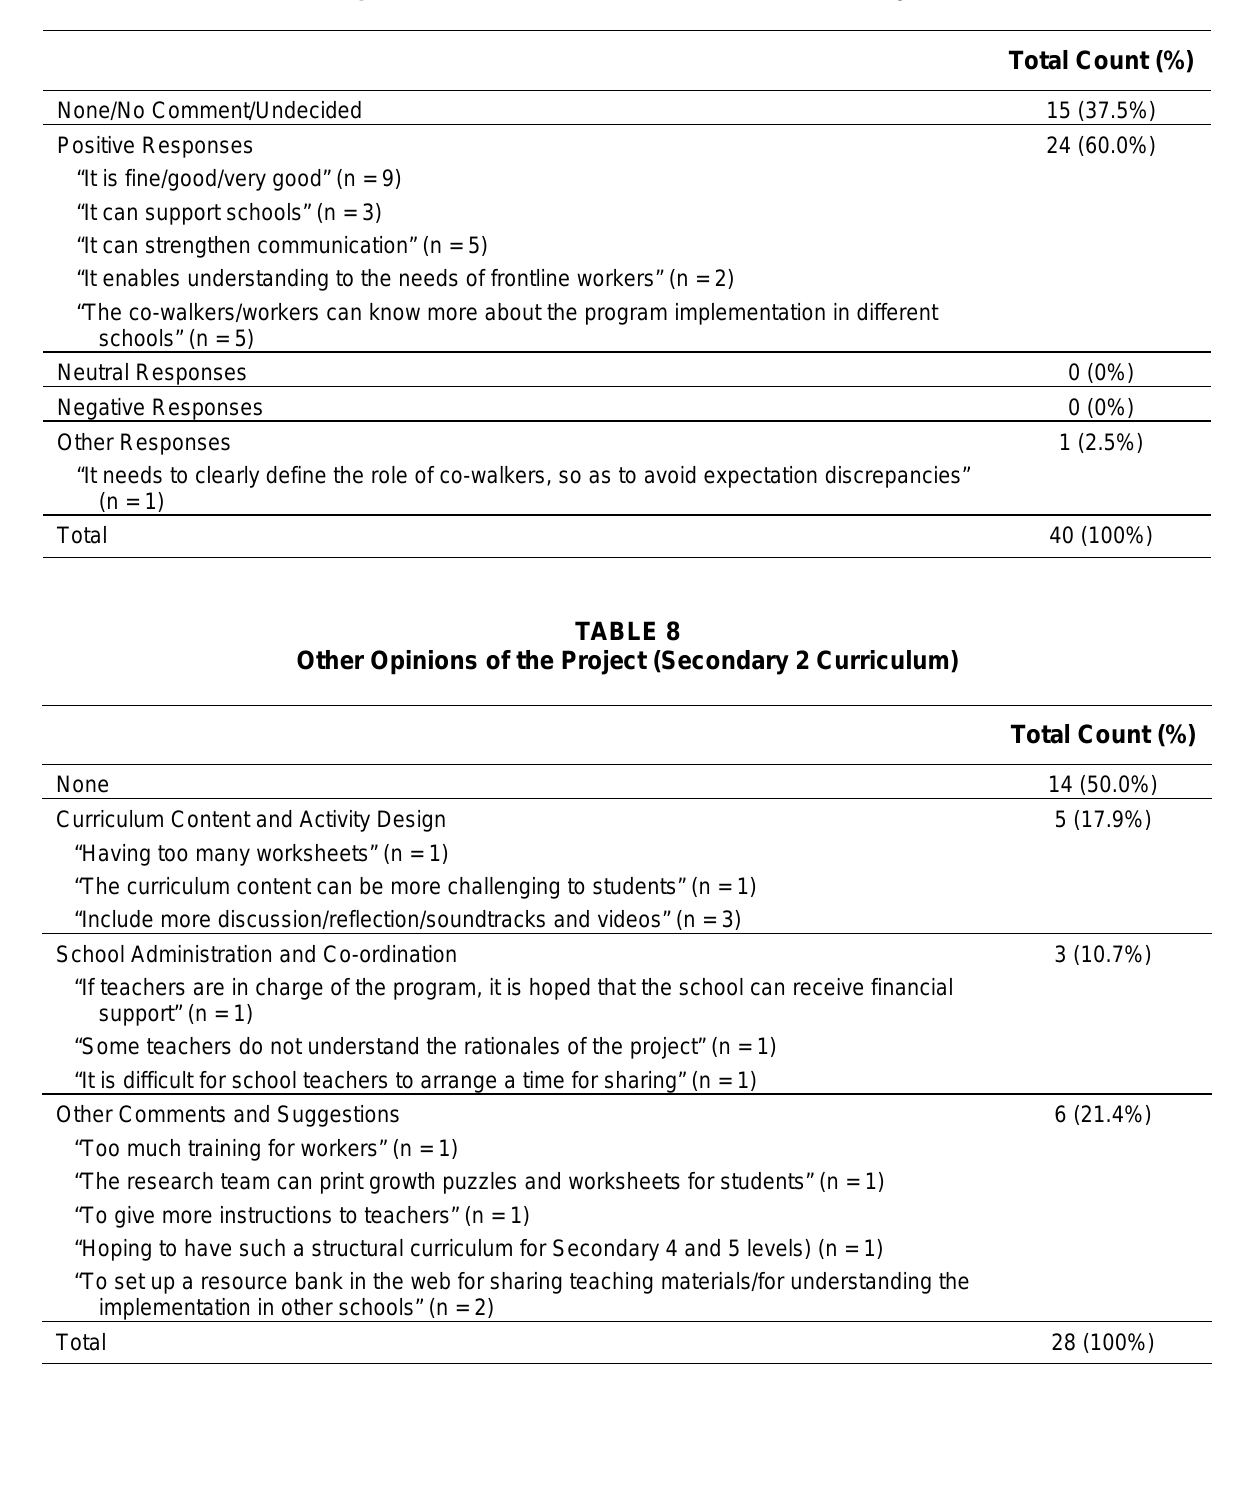
Workers’ Perceptions of the “Co-Walker Scheme” (Secondary 2